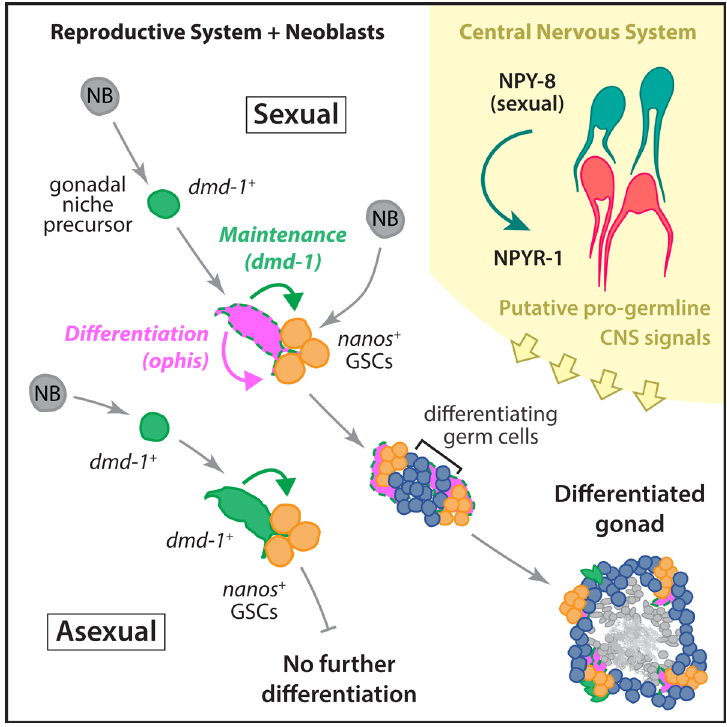
Fig 8. Schematic of the developmental mechanisms involved in planarian testis formation. dmd-1 + cells in both sexual and asexual worms are required for specification of nanos + GSCs. In sexual planarians, these dmd-1 + cells express ophis , which is required for further differentiation of GSCs into mature gametes. NPY-8 signaling, which occurs in the CNS, systemically promotes later stages of germ cell maturation.